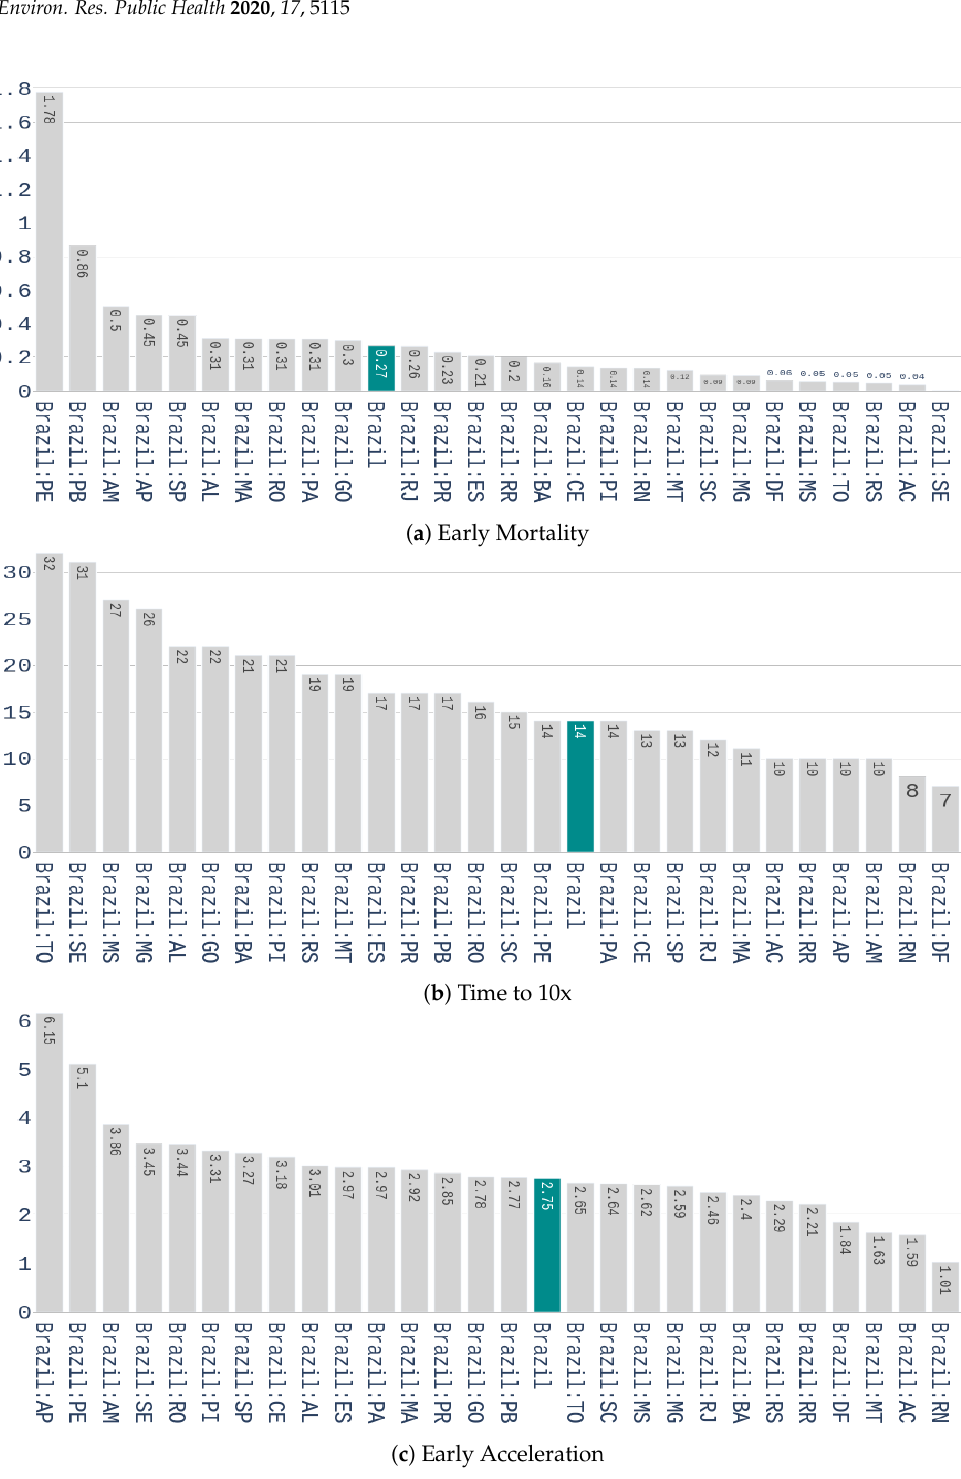
Figure 4. Values of the three features used for characterizing the early response to covid-19 for the Brazilian